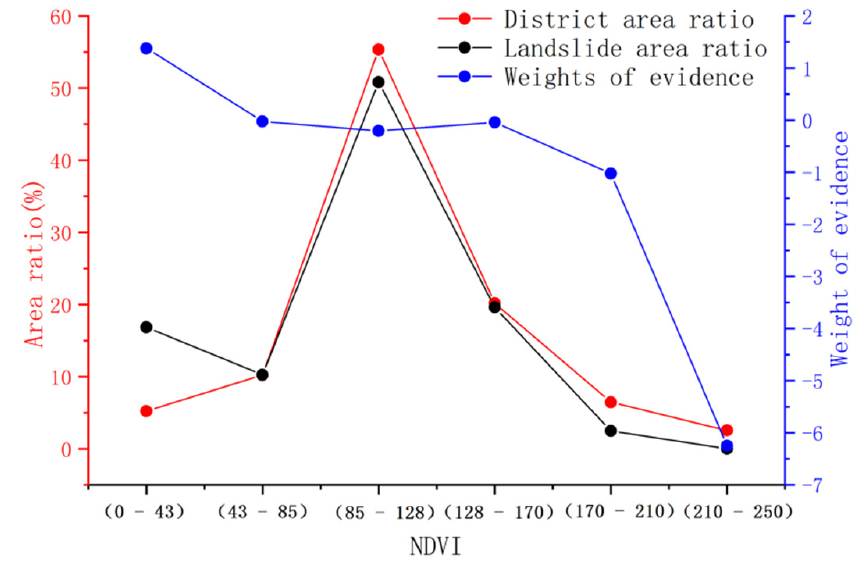
Figure 10. NDVI statistical analysis results.